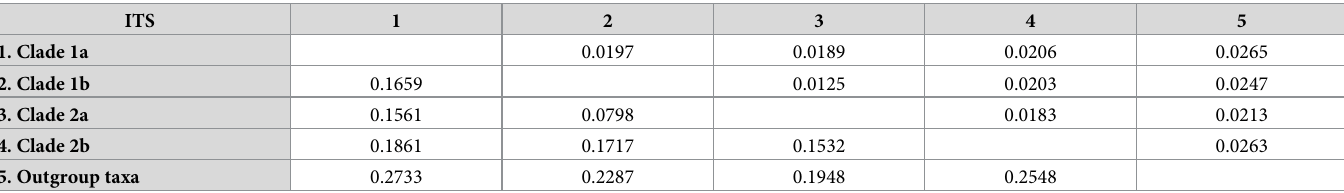
The values represent the number of base substitutions per site obtained by averaging over all sequence pairs between groups. The distances were determined via the log- det (Tamura-Kumar) method using MEGA-X V10.1.8 software. The standard error estimates are shown in